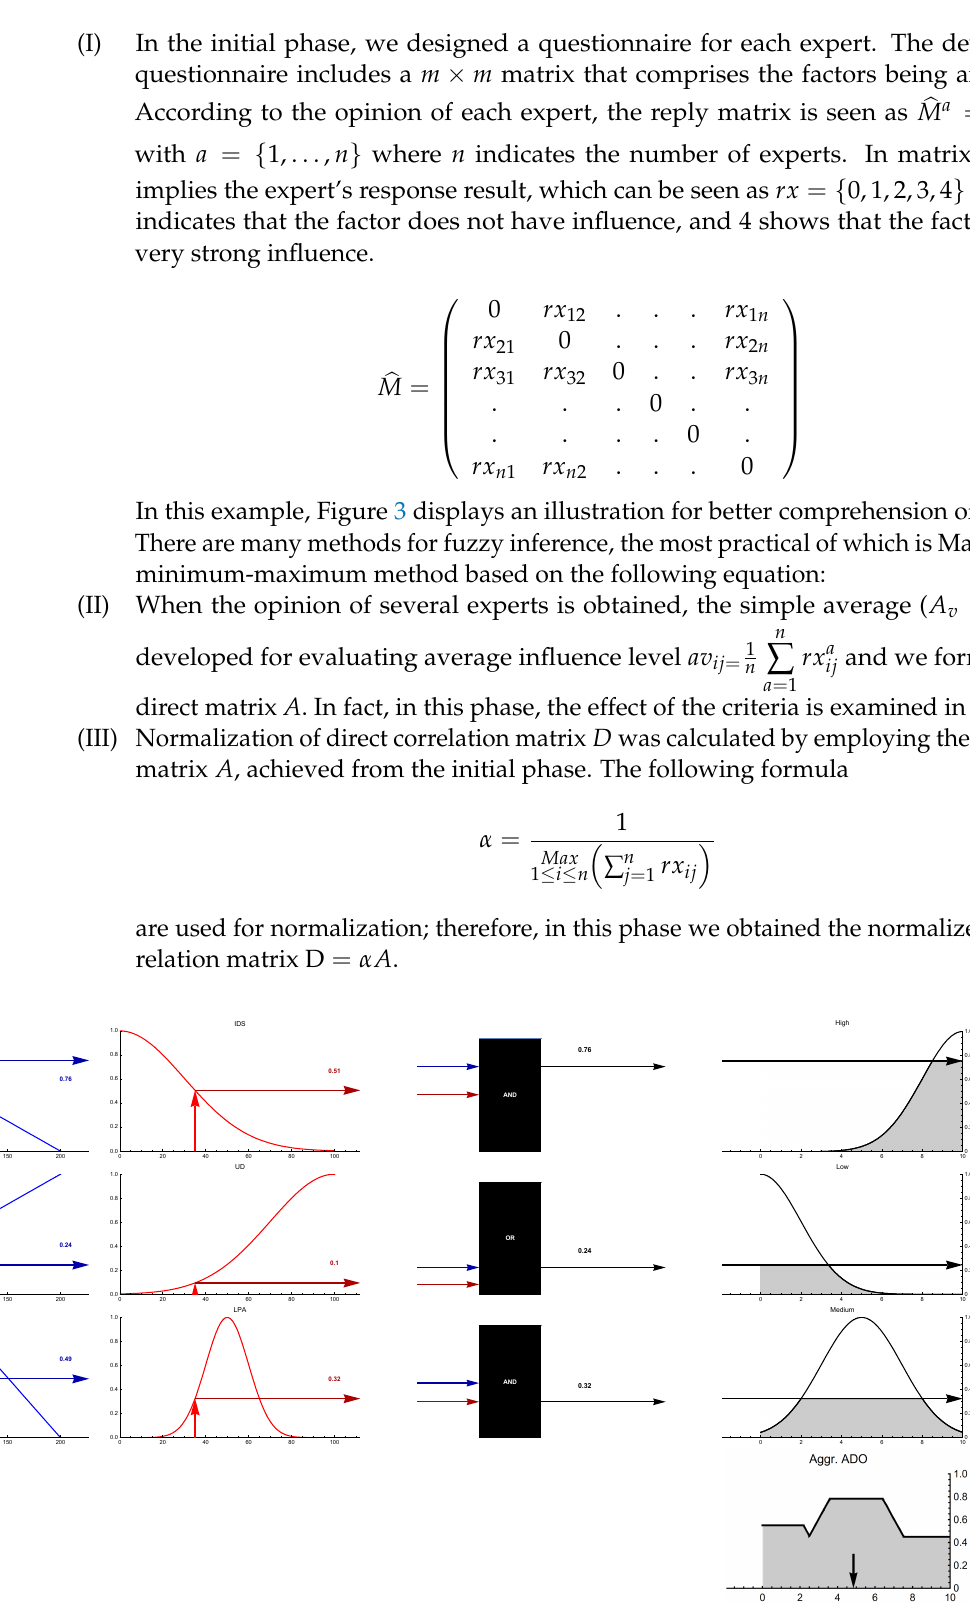
Figure 3. A demonstration of Mamdani fuzzy inference